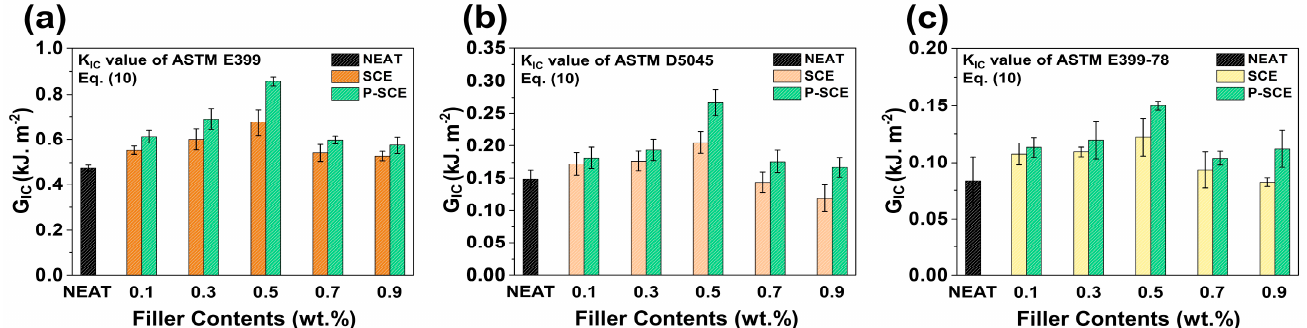
Figure 6. G IC comparison values of SCE and P-SCE composites according to the formula: K IC value of ( a ) ASTM E399, ( b ) ASTM D5045, and ( c ) ASTM